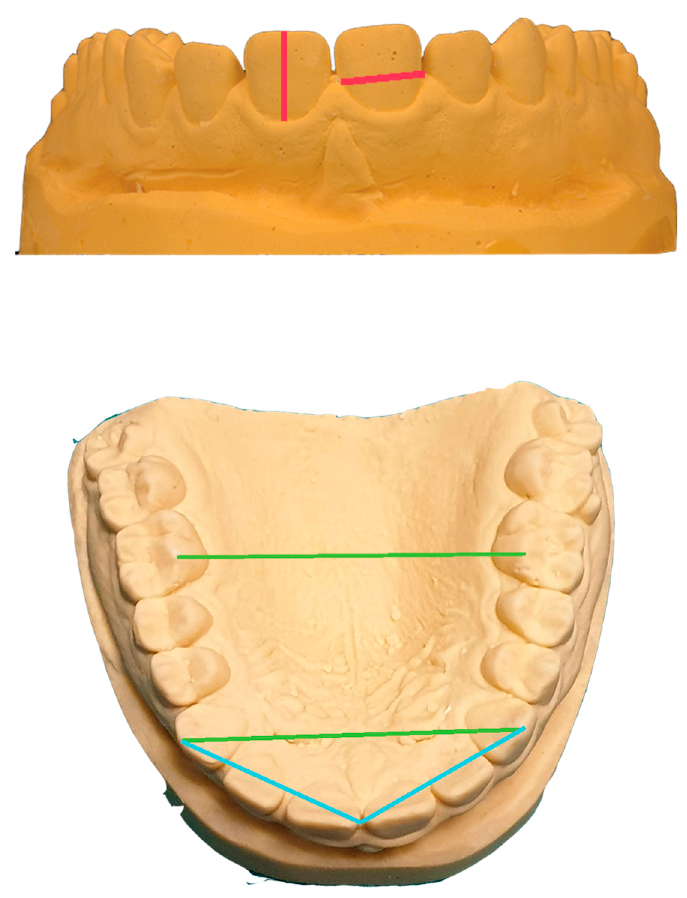
Figure 5. References taken for measurements.